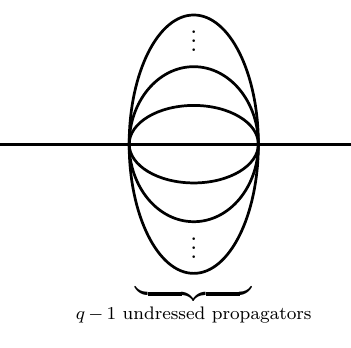
Figure 7. A melonic insertion.